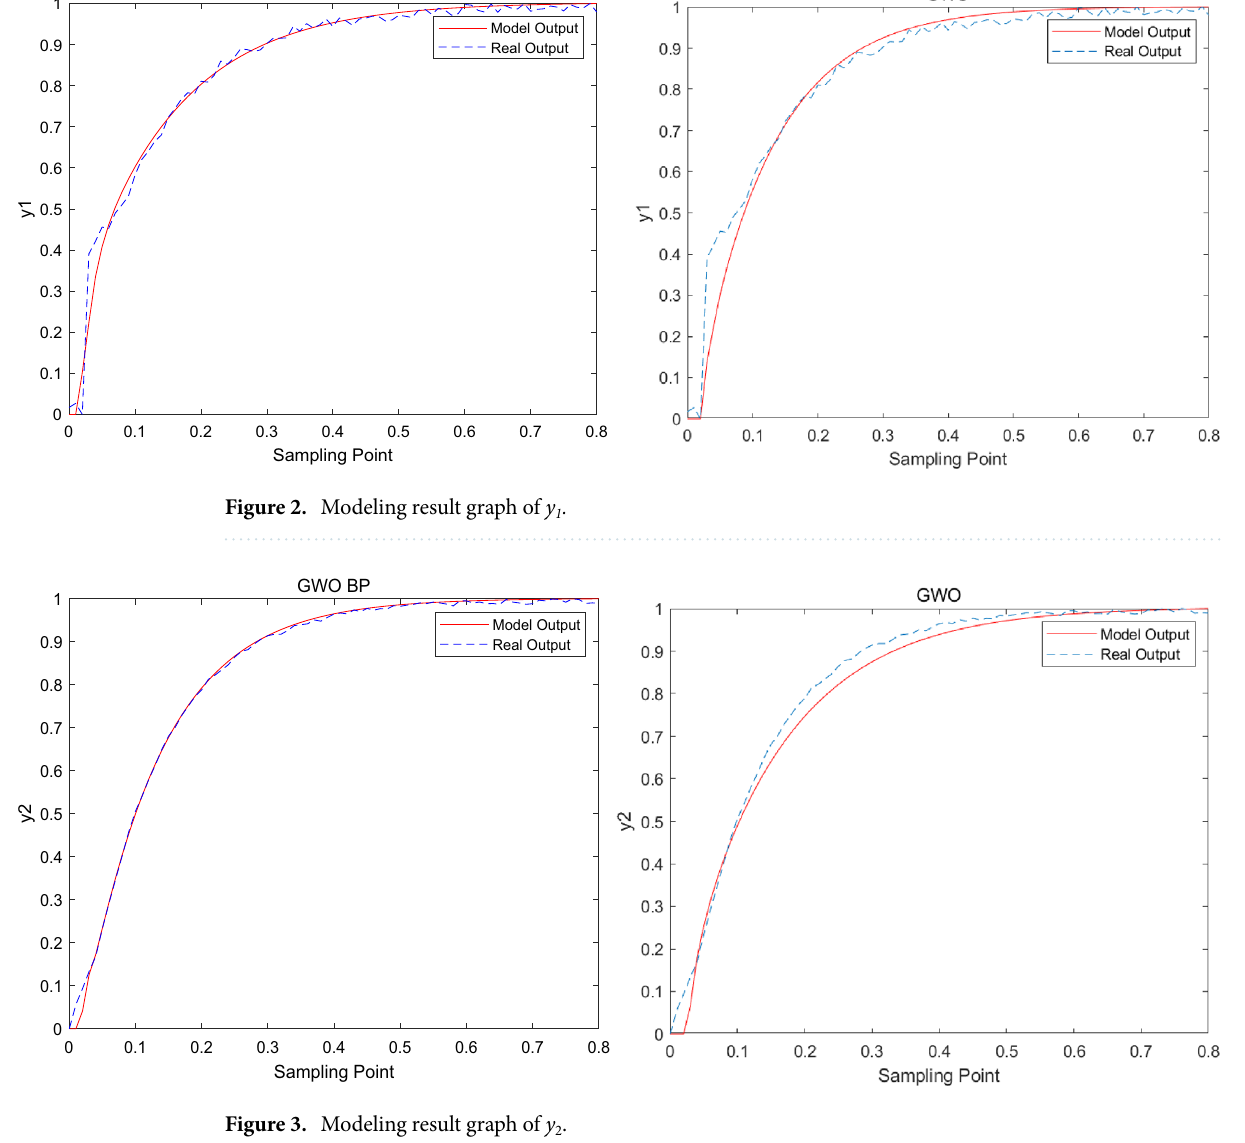
Figure 3. Modeling result graph of y 2